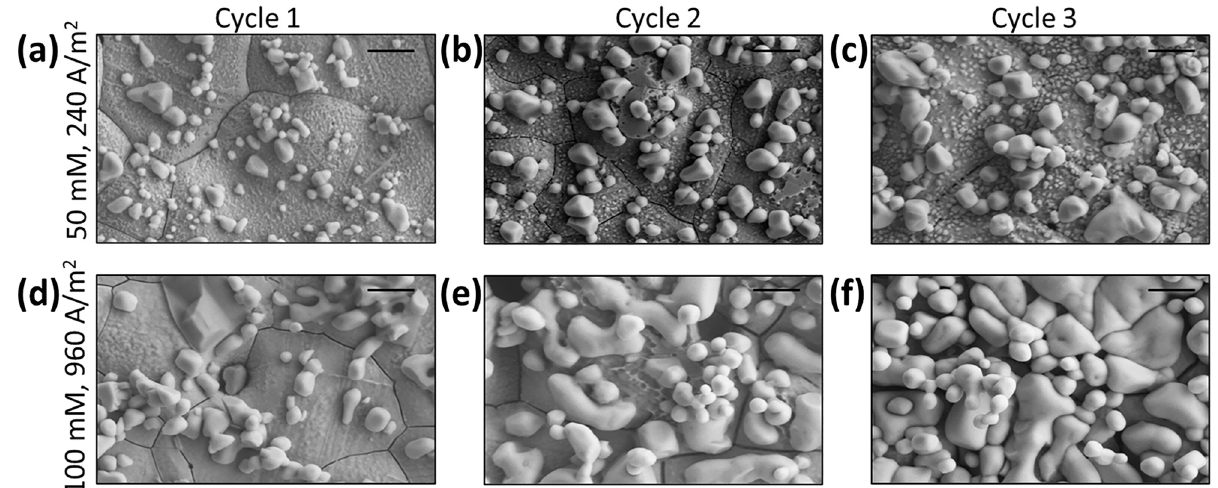
Figure 8. SEM images of sensors after running for ( a , d ) 1 cycle; ( b , e ) 2 cycles; and ( c , f ) 3 cycles, with experimental conditions of 50 mM NaCl, 240 A/m 2 and 100 mM NaCl, 960 A/m 2 , respectively. Each cycle used 5 mL of fresh 20 mM Na 2 SO 4 simple solution at 25 °C. A new electrode was used for each test, and was stopped after different cycle numbers. All scale bars are 2.5 μ m.